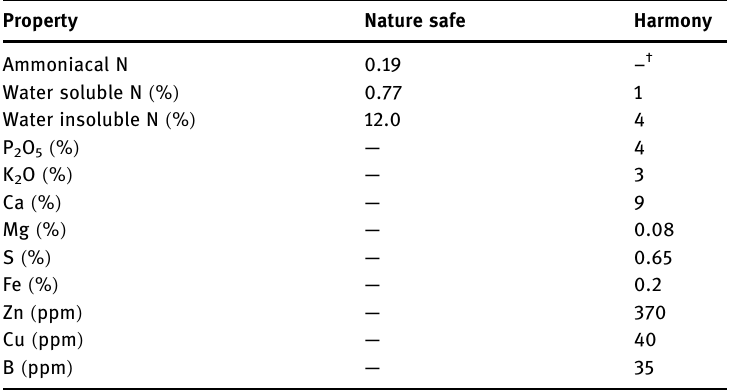
Table 1: Chemical composition of commercial NSF and HAG fertilizers used